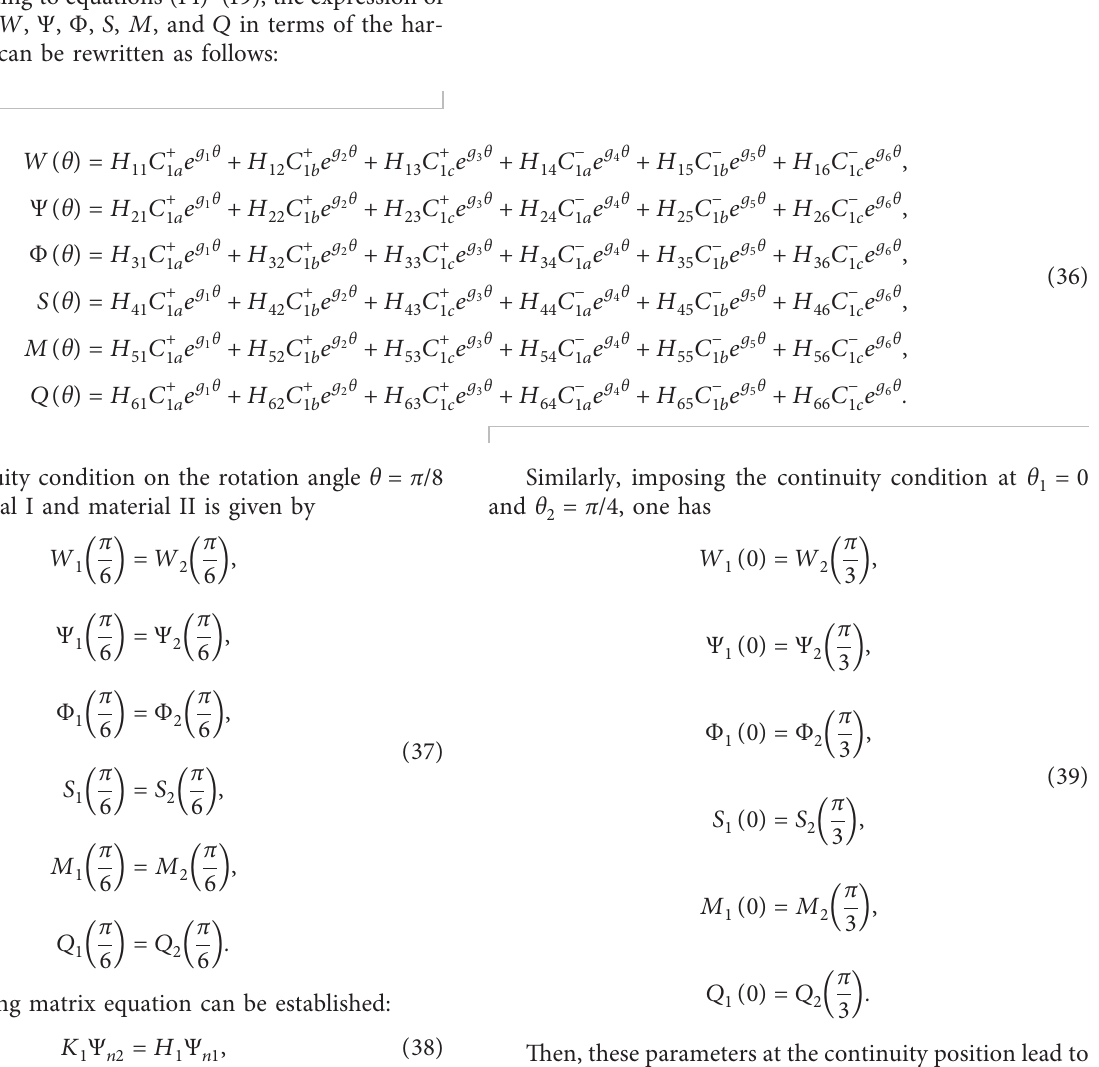
Table 1. According to equations (14)–(19), the expression of